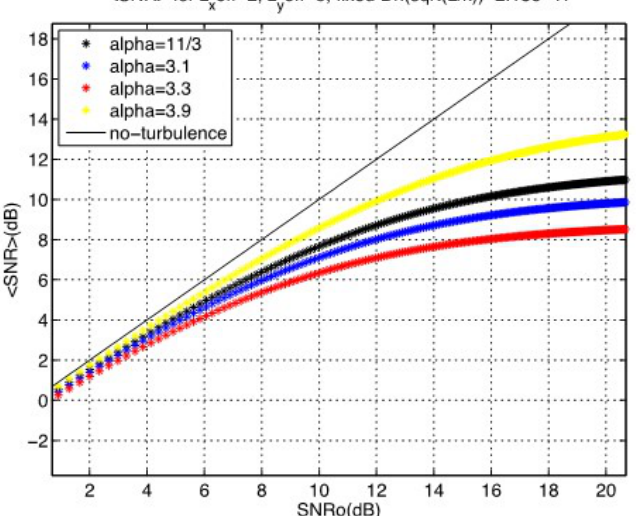
Figure 19. Mean SNR with fixed structure function for fixed values of anisotropic factors (shown as z x eff and z y eff). Reprinted with permission from Reference